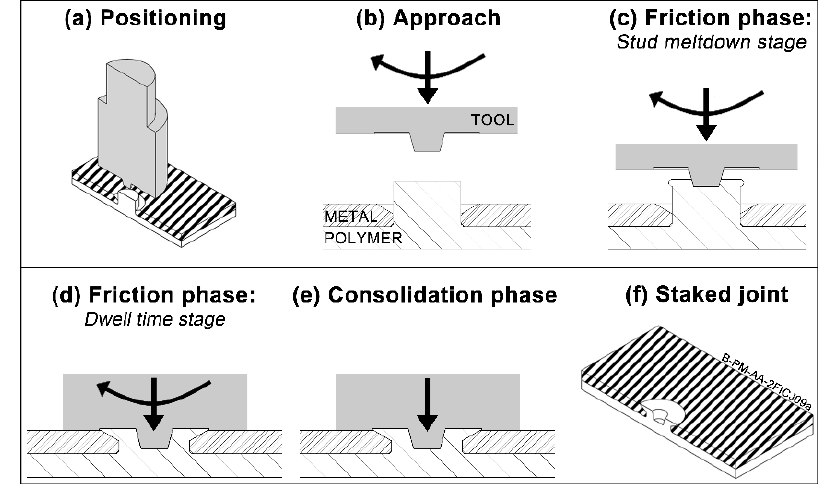
Figure 2. ( a – f ) Steps of the Friction-based Injection Clinching Joining (F-ICJ) process. Adapted from